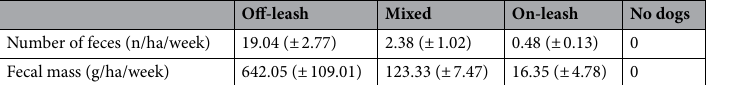
Table 2. Dog fecal contamination of urban parks of the City of Calgary assessed during a survey on random points within urban parks in the City of Calgary (AB, Canada) in the year 2011. Data were classified into 4 categories based on the parks’ leash policy. The fecal contaminations are reported as mean (± SE) number and mass (in gram) of feces found in each of the leash policy categories per hectare per week. “Off-leash” parks do not require dogs to be on leash, “On-leash” parks require dogs to be on the leash all the time, and “mixed” park has areas that are off-leash and on-leash. “No dogs” parks do not allow dogs at all.